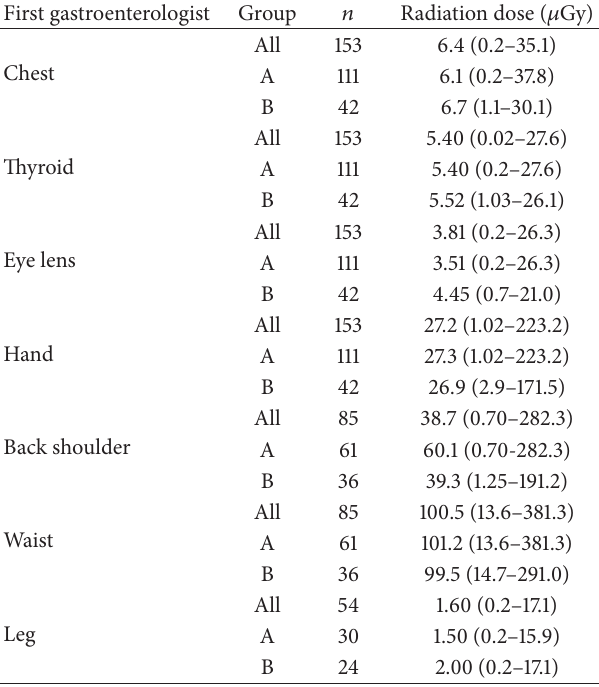
Table 4: First gastroenterologist mean radiation doses ( 𝜇 Gy) for groups A and B per ERCP procedure. The range is in parenthesis.